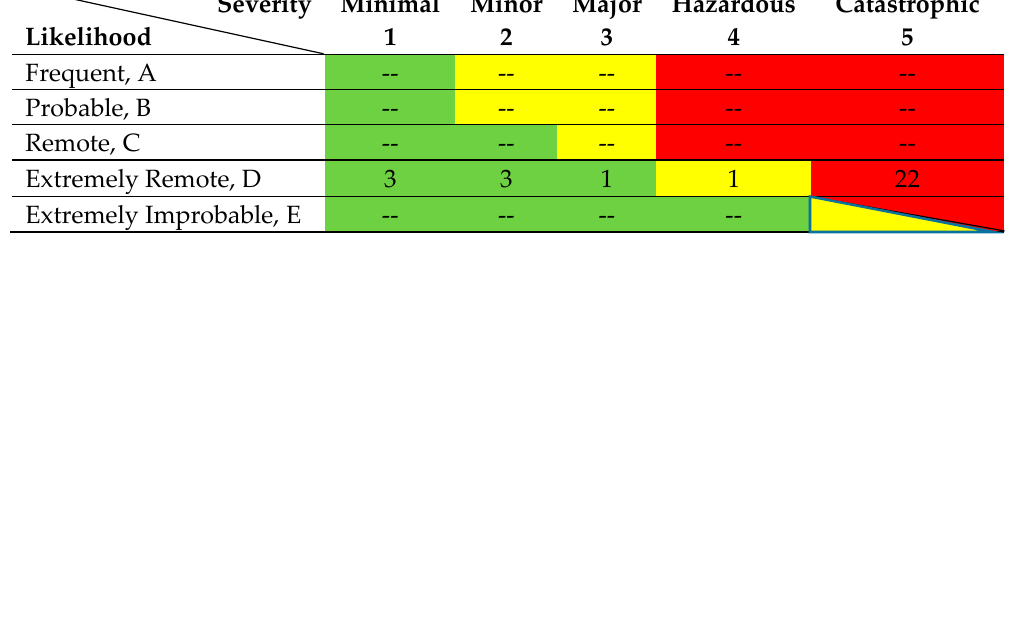
Table 13 . Risk matrix with look-ahead time 60 s, head-to-head